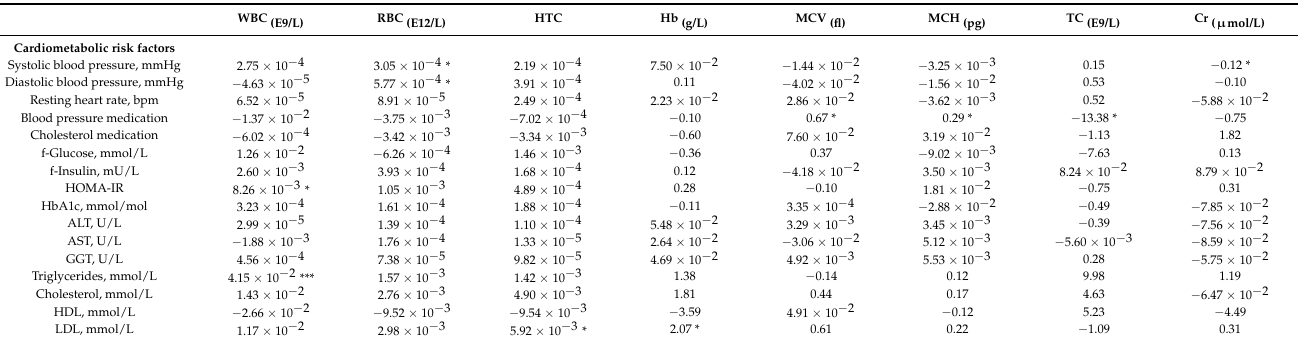
Table 3. Age-, sex- and BMI-adjusted linear mixed regression estimates (B values) between car- diometabolic risk factors and blood count parameters and Cr (model 2).